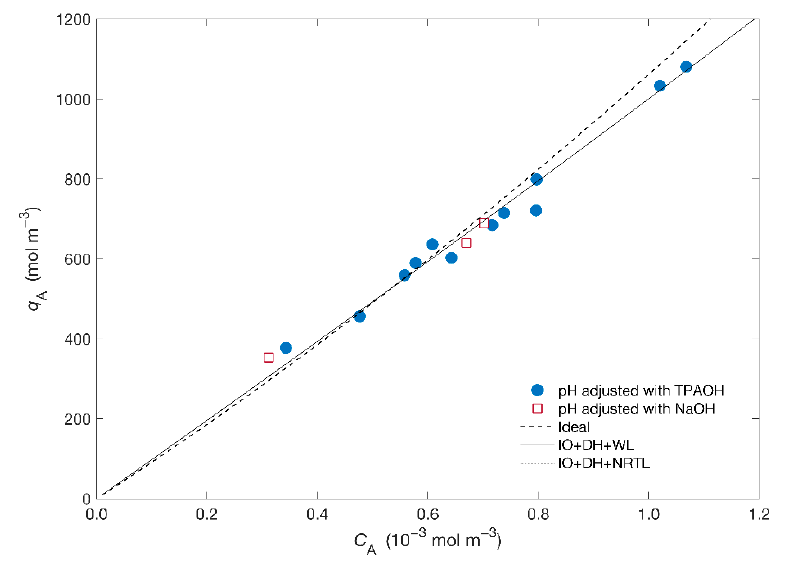
Figure 1. Equilibrium data (symbols) and isotherm modelling (lines) results for the system